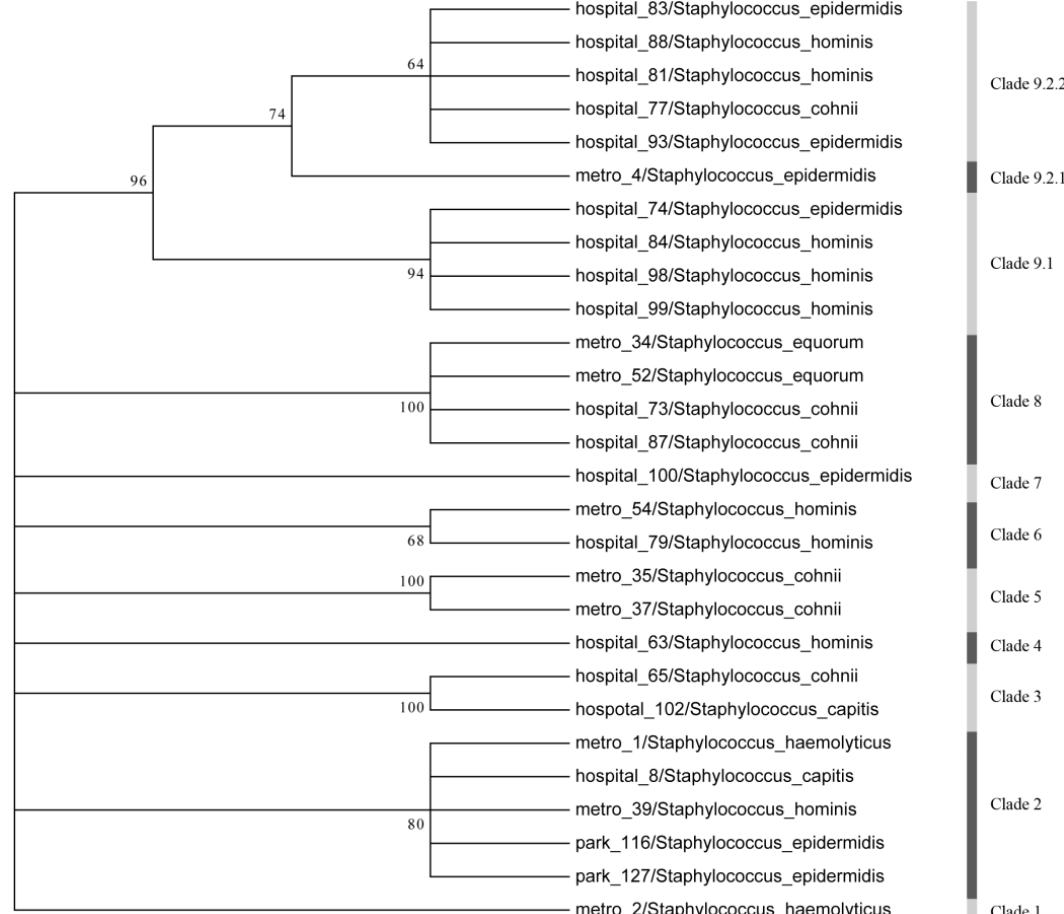
Figure 3. Phylogenetic analysis of qac . High levels of variability were found in qac gene fragment sequences from metro stations and treatment rooms. Samples from the same group were more